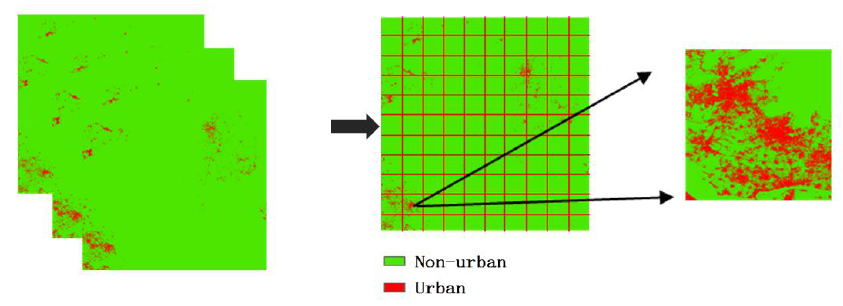
Figure 6. Comparison of the accuracy absolute bias between the three distribution methods and ground truth (the blue bars show the bias between the EA accuracy and ground truth. The green bars show the bias between the PA accuracy and ground truth. The yellow bars show the bias between the OPA accuracy and ground truth).